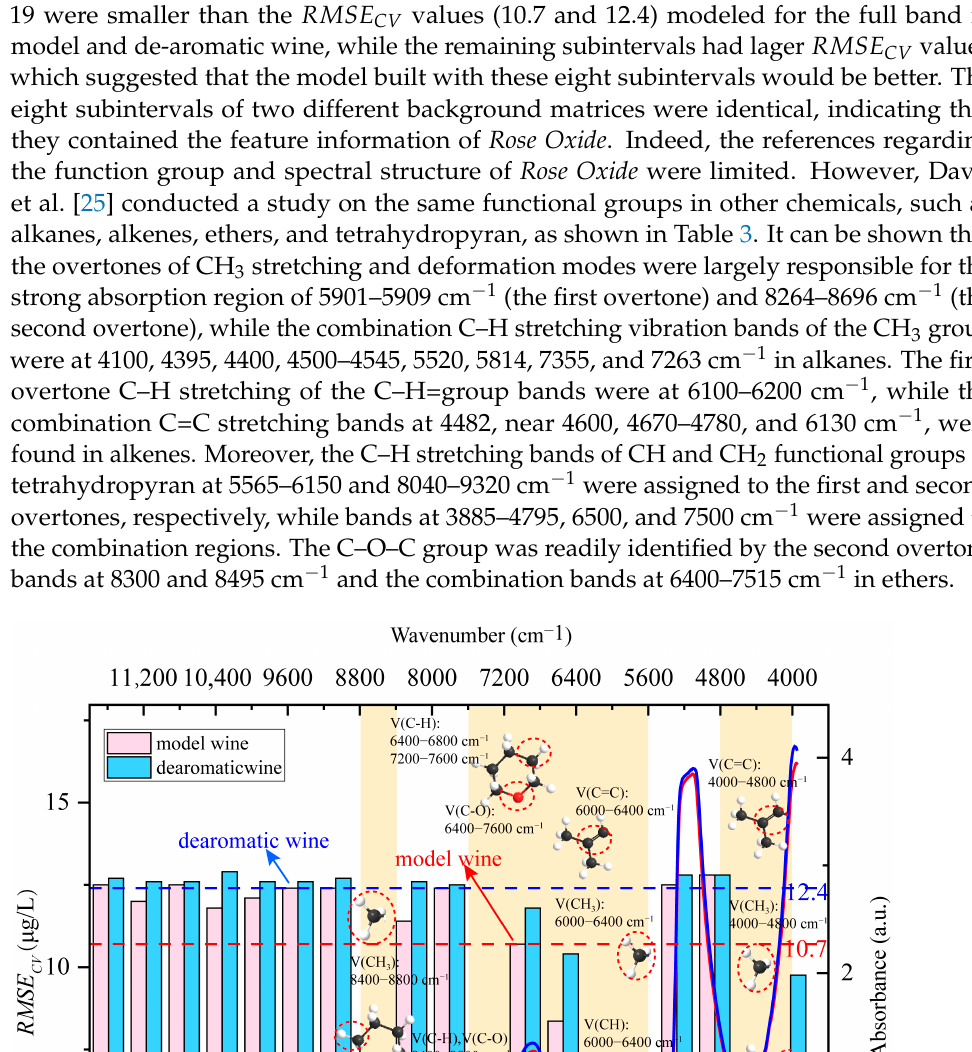
Table 3. Spectral mapping analysis of functional groups in similar substances of Rose Oxide .